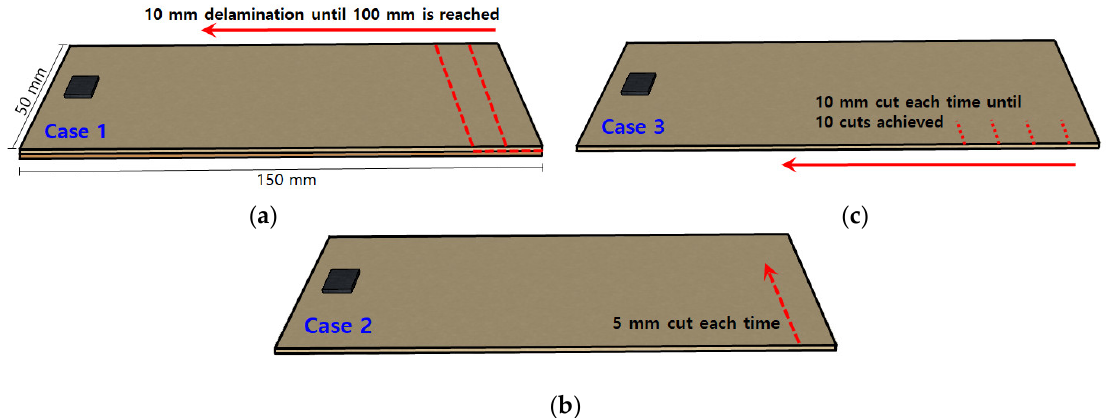
Figure 4. ( a ) Case 1—Delamination defect between two composite plates; ( b ) Case 2—Increasing crack damage at fixed location; ( c ) Case 3—Progressive crack damage towards the PZT patch.